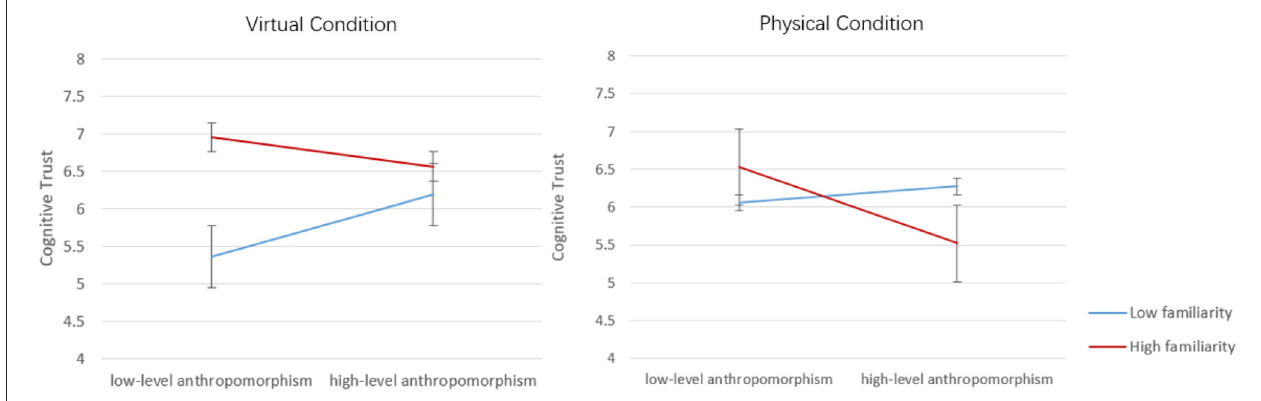
FIGURE 7 | The moderating role of user familiarity on the influence of anthropomorphism level for virtual and physical